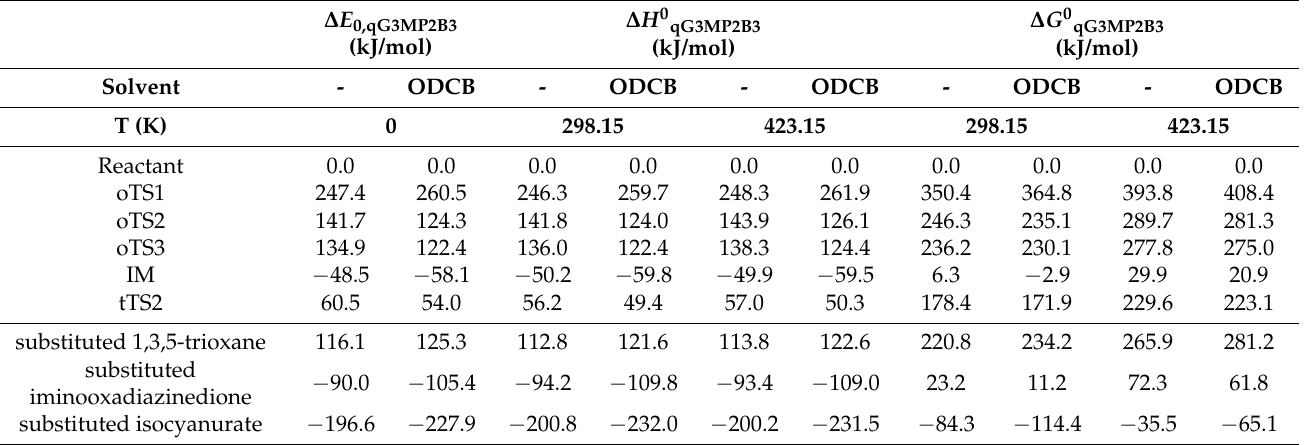
Table 3. Thermochemical properties calculated in the gas phase and ortho-dichlorobenzene (ODCB), including zero-point corrected relative energies ( ∆ E 0,qG3MP2B3 ), relative enthalpies ( ∆ H 0 qG3MP2B3 ), and relative Gibbs free energies ( ∆ G 0 qG3MP2B3